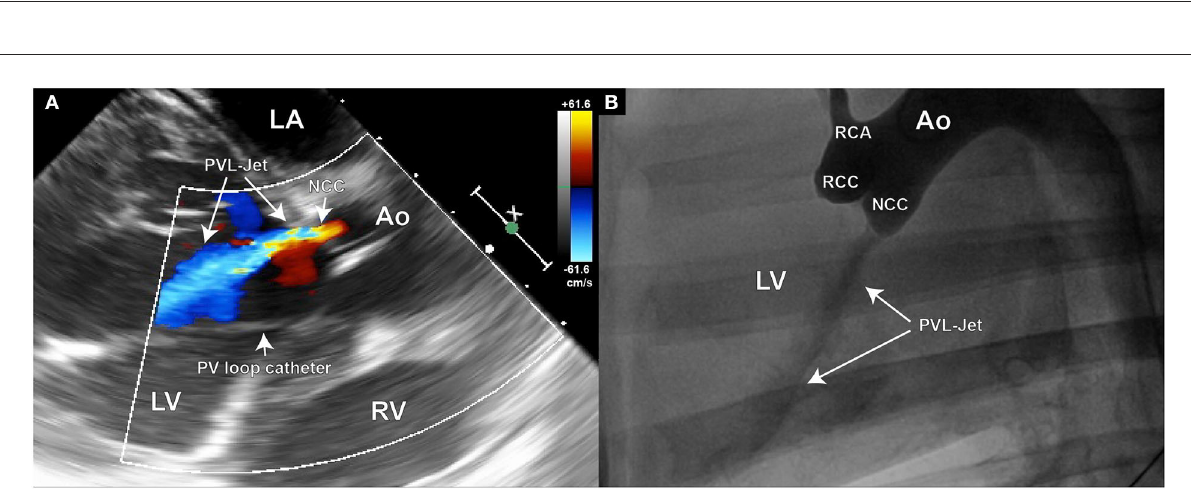
FIGURE4 Echocardiography and aortography can be used for verification of the aortic valve defect; (A) Color Doppler image of the aortic insufficiency jet created in the NCC region of the aortic valve; (B) Aortographic image of the same animal in latero-lateral position also demonstrating the existence of the regurgitant jet. Such images can later be used for densitometric quantification of the regurgitant